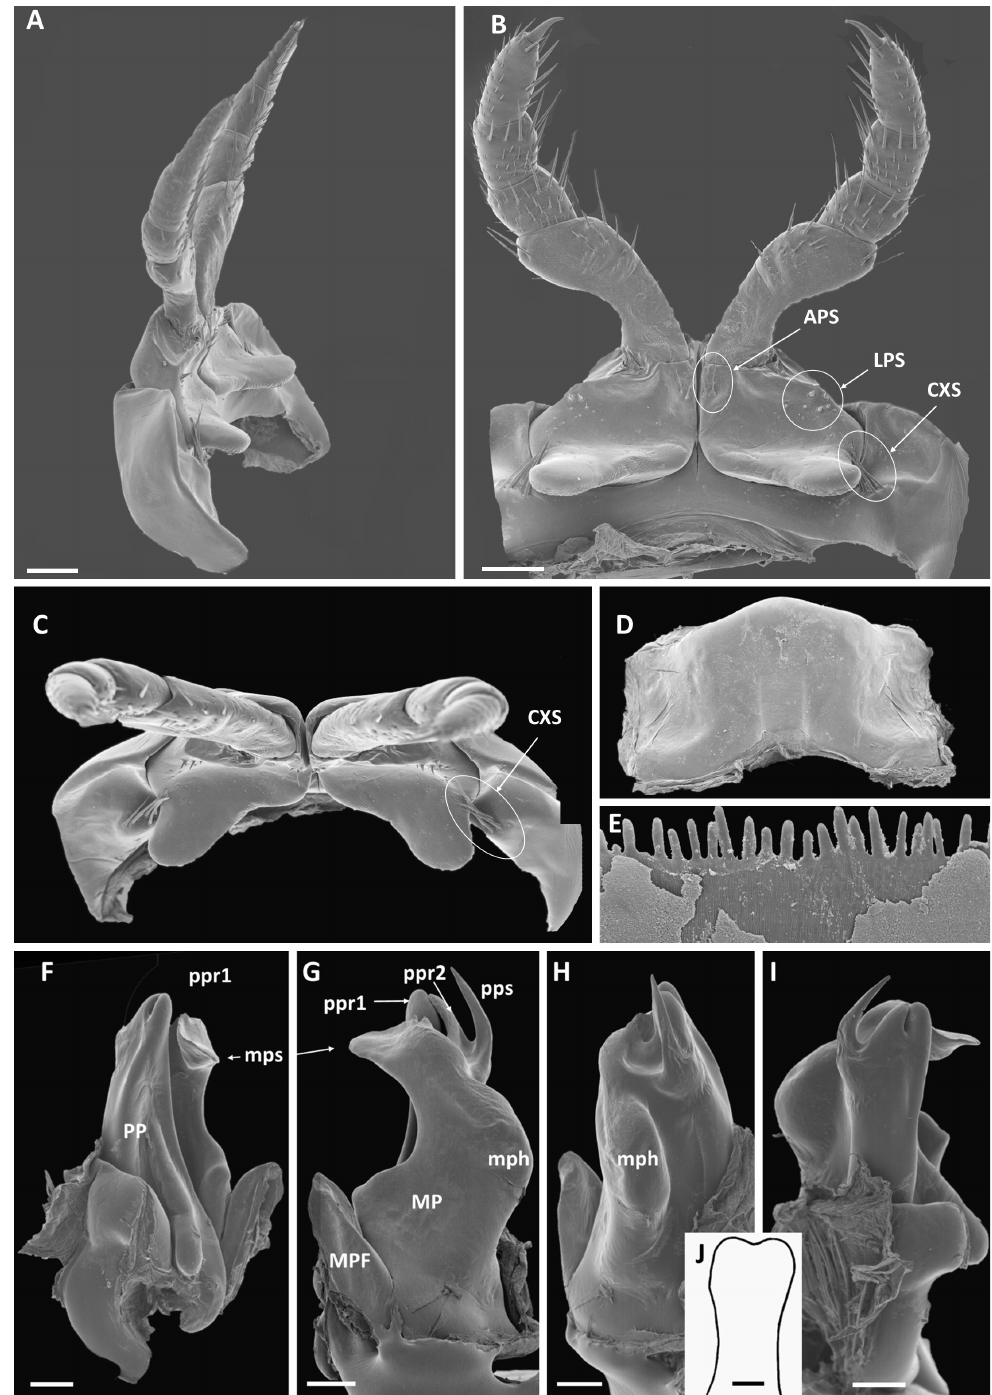
Fig. 73. Xystopyge proplicatus Frederiksen & Enghoff, 2012, specimen from Kasanga (NHMD 621774). A–C . First pair of legs. A. Sublateral view. B. Anterior view. C. Ventral view. D . Sternum 9. E . Midbody dorsal limbus. F–I . Left gonopod coxa. F. Anterior view. G. Mesal view. H. Posterior view. I. Lateral view. J . Gonopod sternum. Abbreviations: APS = mesapical prefemoral setae; CXS = coxosternal setae; LPS = lateral prefemoral sensilla; MP = metaplica; MPF = metaplical flange; mph = metaplical ‘hump’; mps = metaplical ‘snout’; PP = proplica; ppr1 , ppr2 = proplical processes; pps = proplical spine. Scale bars: A–D, F–J = 0.2 mm; E = 0.01